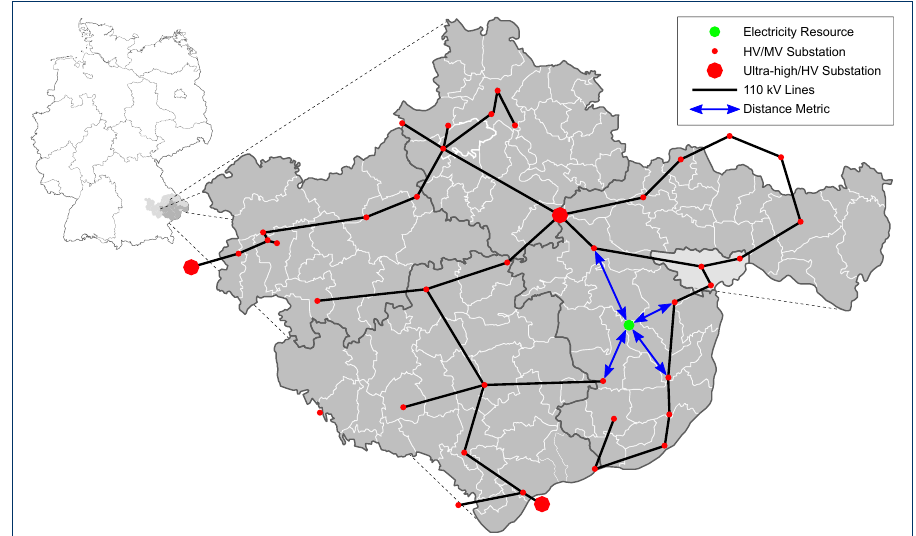
Figure 2: Mapping of electric resources to k-nearest HV/MV substations,